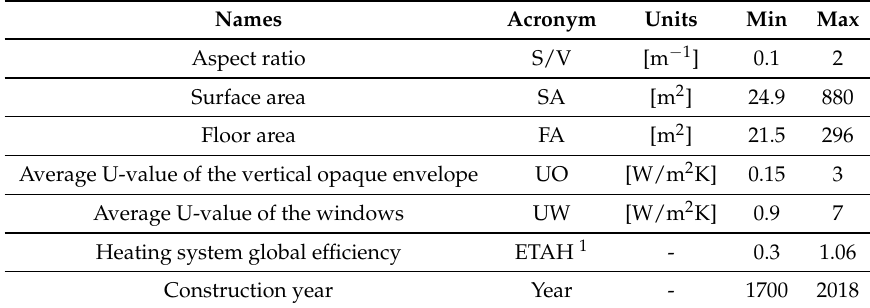
Table 2. Selected attributes characterizing EPCs and corresponding validity ranges.